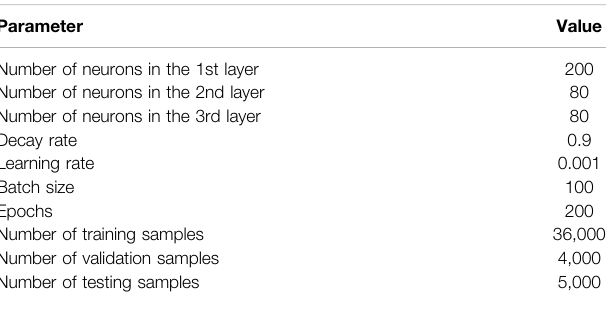
TABLE 2 | DNN ’ s parameters.